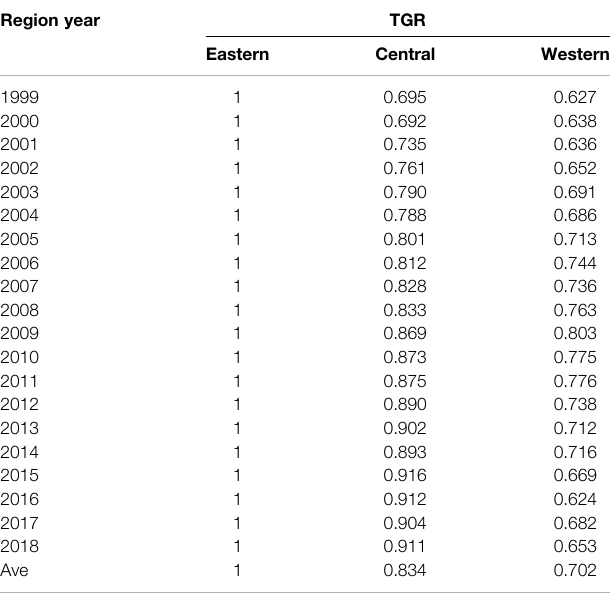
TABLE 3 | Analysis of the technology gap ratio (TGR) of innovation ef fi ciency in each region. Region year